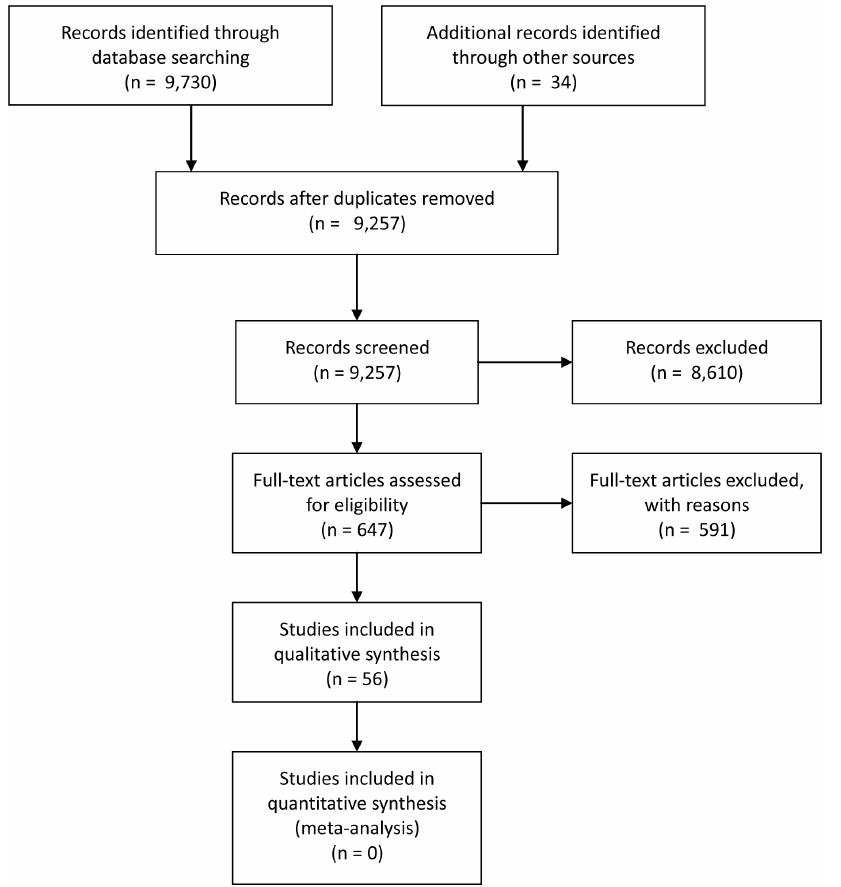
Figure 1. PRISMA flow diagram.